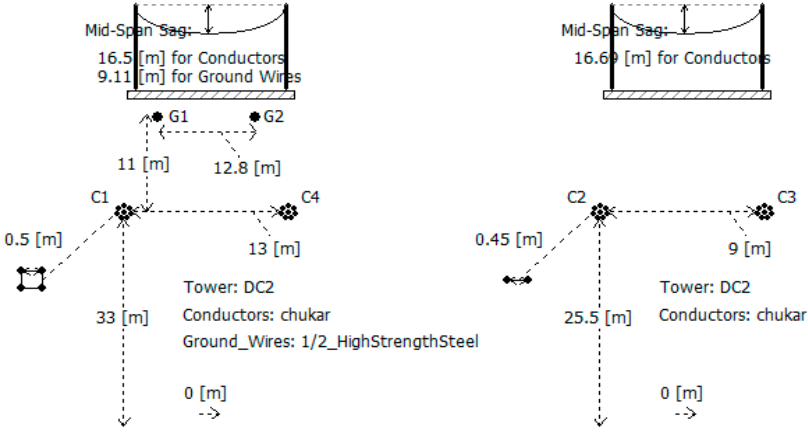
Figure 4. Configuration of a 500 kV DC transmission line.